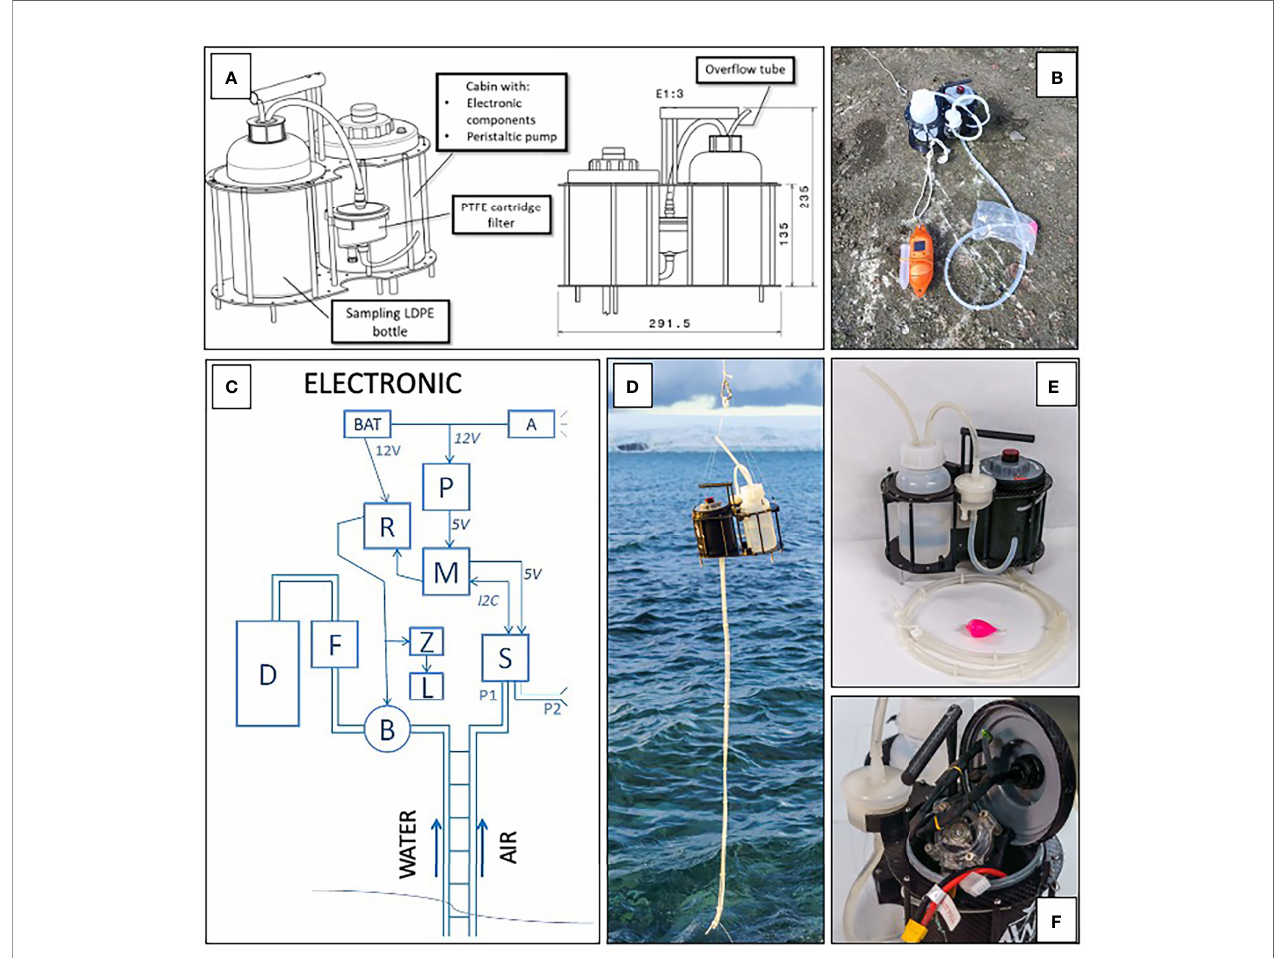
FIGURE 1 | The AWA system: (A) schematic representation of the device components (Dronetools © ) with sizes expressed in mm; (B, D, E) pictures of the whole system including, AWA and multiparameter probe [CastAway-CTD ® , orange instrument: (B) ]; (F) picture of components inside the cabin; (C) system components scheme (BAT, lipo battery; A, low battery alarm; P, DC-DC 5V power supply; R, relay 12 V; M, microcontroller; S, pressure sensor (P1, tube air pressure; P2, tube atmosphere pressure); Z, active pump buzzer; L, active pump fl ash light; B, peristaltic pump; F, PTFE Cartridge fi lter; D, sampling LDPE bottle; I2C, sensor communication